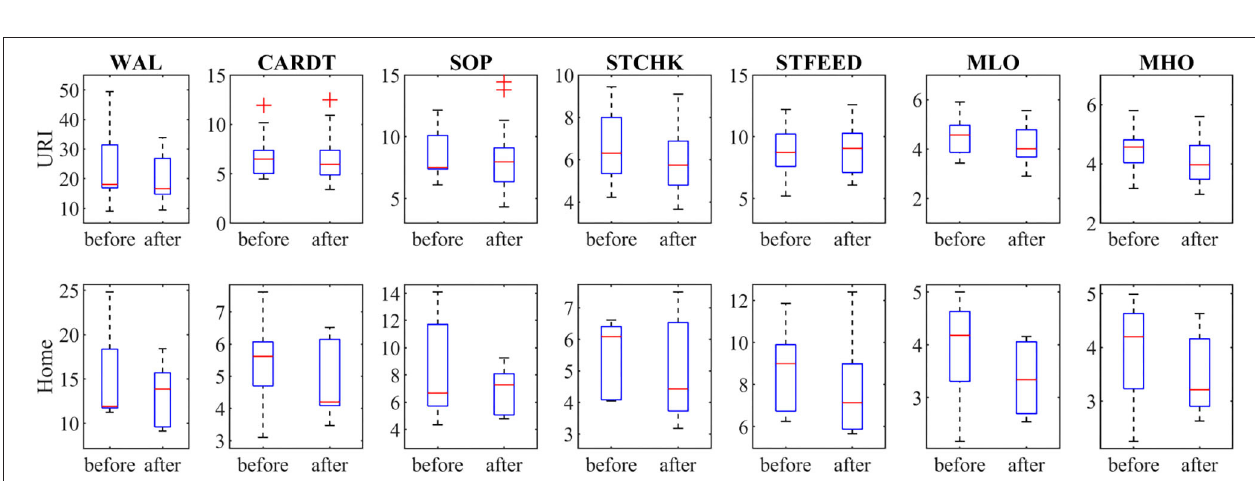
FIGURE 4 | Shows the outcomes of the seven sub-tests of the Jebsen Hand Function Test for dominant/affected hand (WAL, writing a letter; CARDT, card turning; SOP, picking small objects; STCHK, stacking checkers; STFEED, stimulated feeding; MLO, moving light; MHO, moving heavy